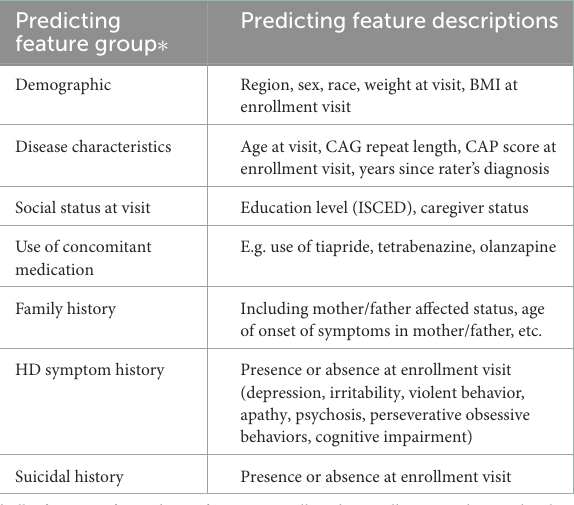
TABLE 1 Candidate features tested for cluster prediction using a supervised machine learning method (XGBoost). Predicting feature group